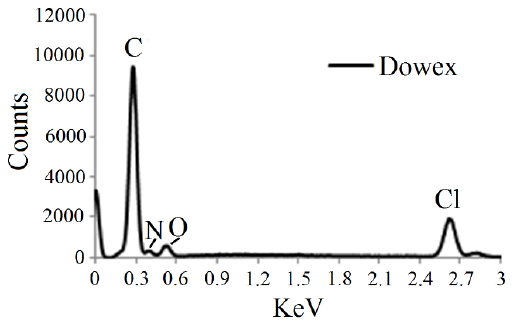
Figure 1. EDS analysis of Dowex 21K XLT.